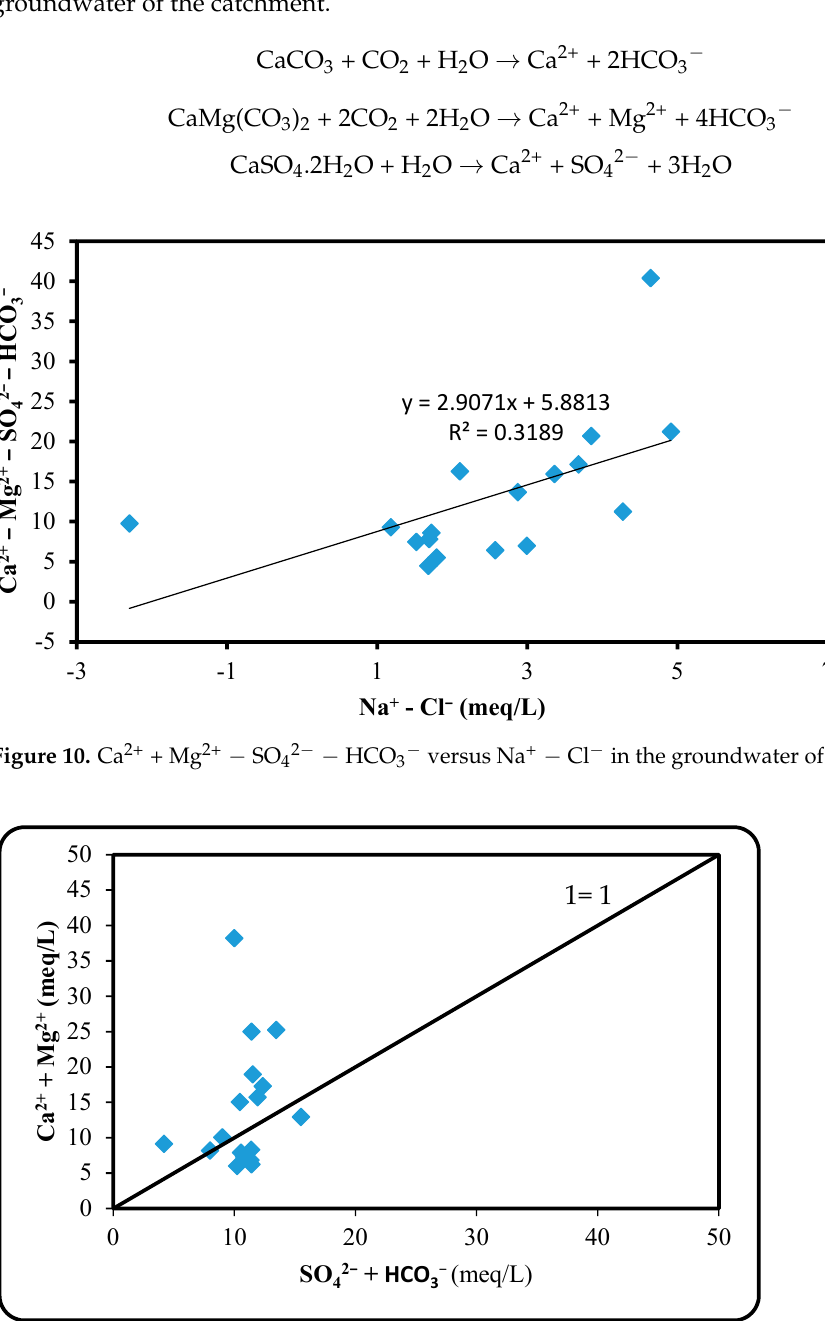
Figure 12. ( a ) Ca 2+ versus SO 42 − and ( b ) Ca 2+ versus HCO 3 − in the groundwater of the catchment. In conclusion all the above computations of ratios and chloro-alkaline indices and bivariate plots depict that silicate weathering, dissolution of carbonate minerals, and gyp- sum and ion exchange are the major geochemical processes that control the groundwater chemistry in the studied area. Among these, however, the significant composition-con- trolling processes or salinization mechanisms are dissolution of carbonate minerals and gypsum and silicate weathering.